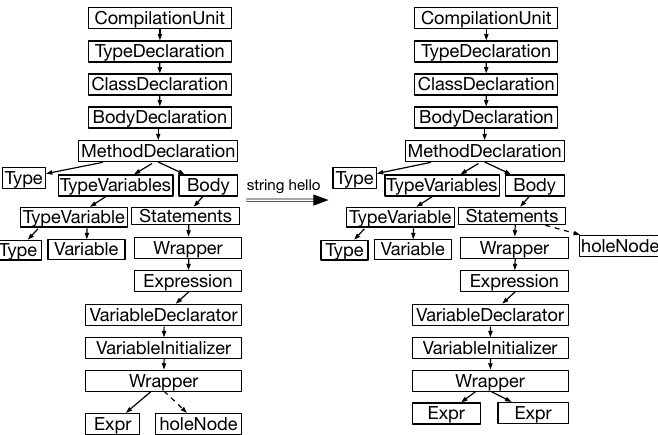
Figure 5. An example of clever move